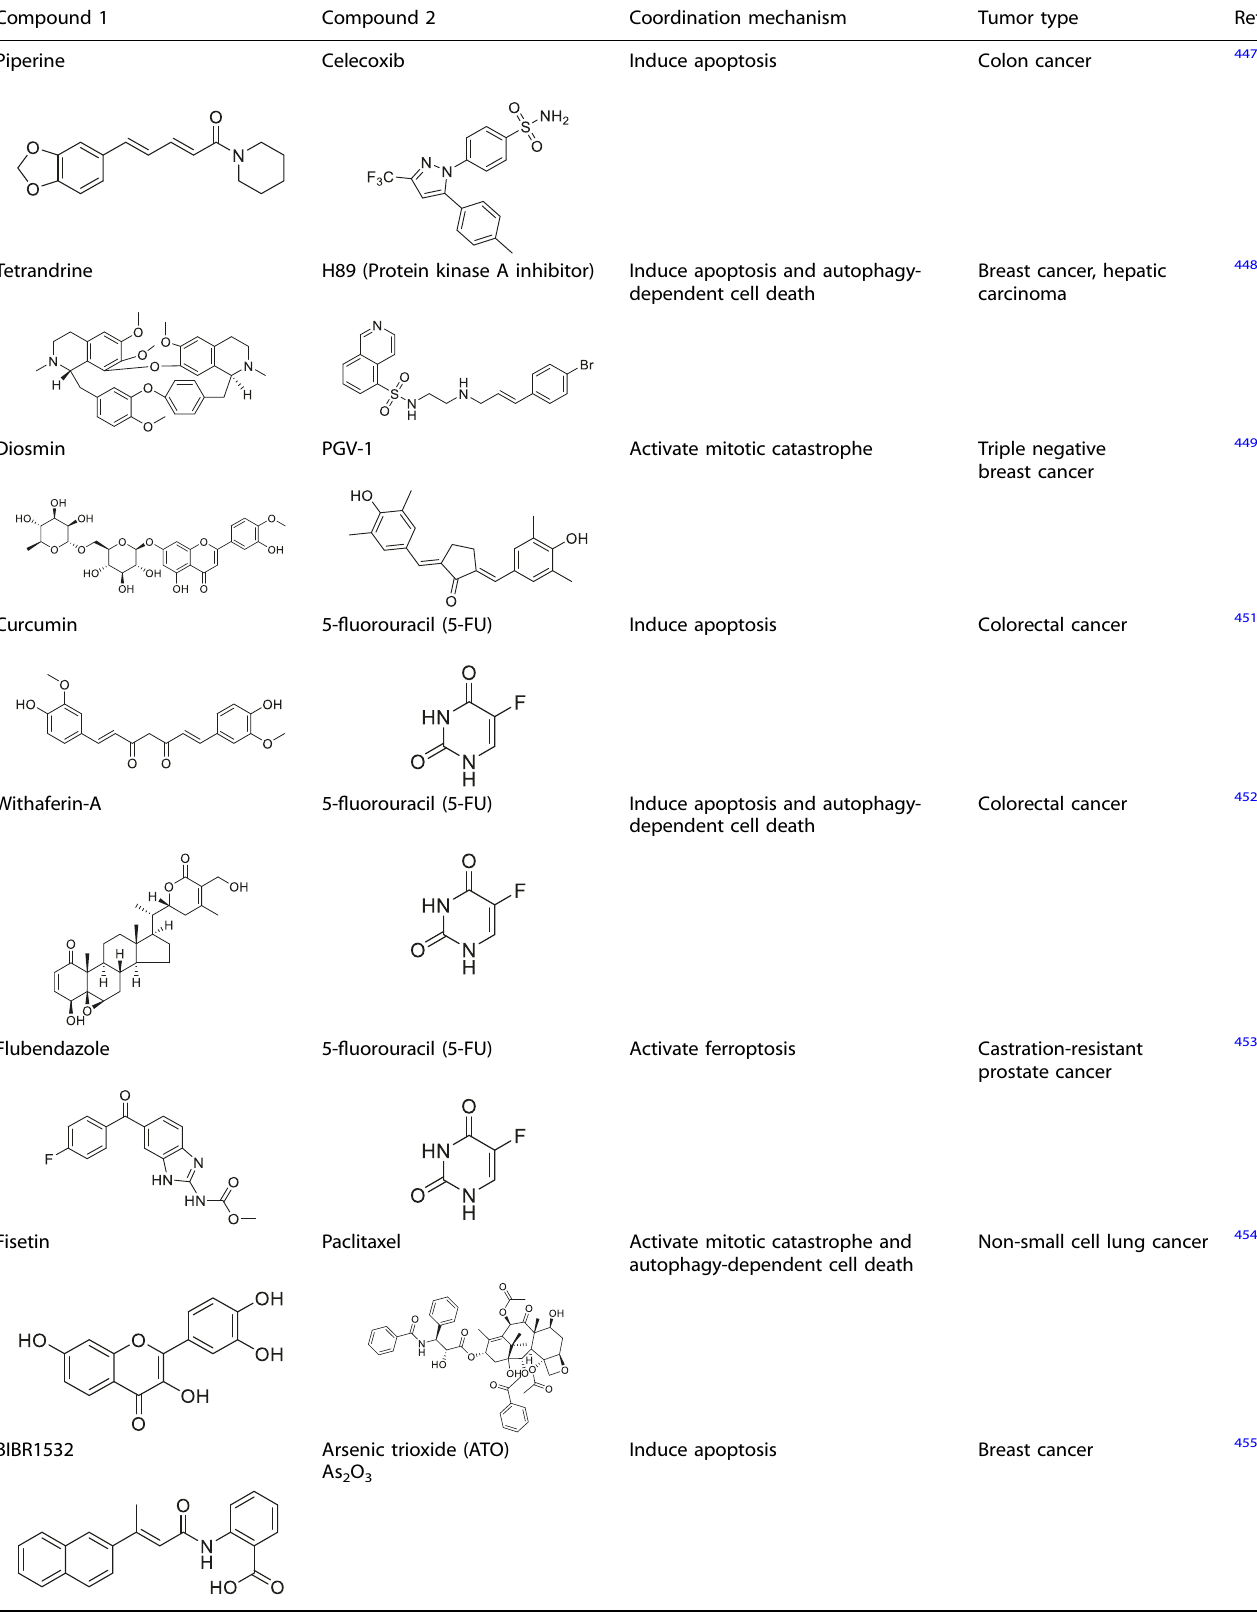
Table 16. Combination therapy for synergistic effects in